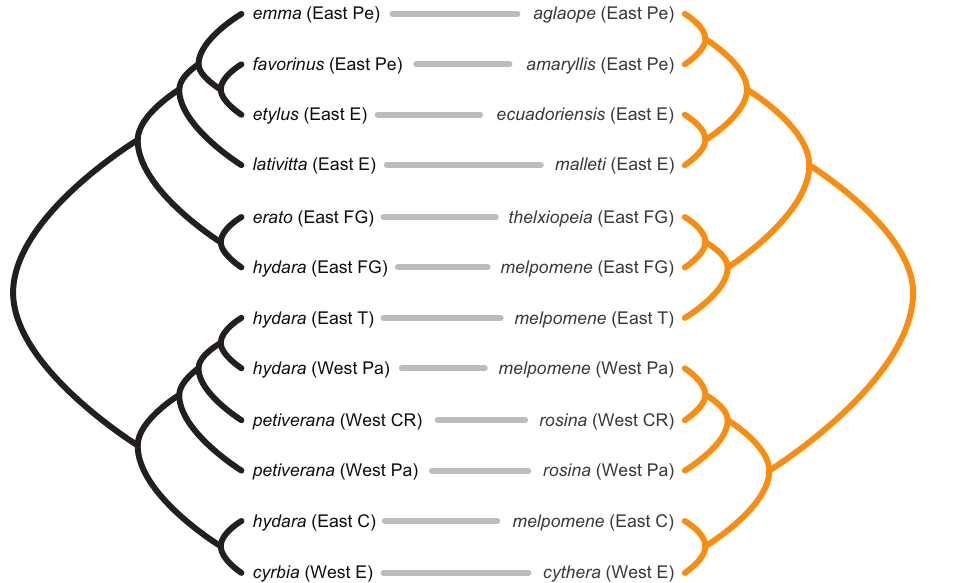
Figure 2. Phylogenies of H.erato and H.melpomene illustrating branching orders of co-mimetic country level populations within each species. Example phylogenies independently estimated for H. erato (black, left) and H. melpomene (orange, right) using the Minimise Deep Coalescence (MDC) method [32]. These correspond to cophylogenetic analysis ‘‘separate MDC countries 1’’ in Table 1. H. erato / H. melpomene co- mimics (see Figure 1) are indicated by grey lines. This is one of several possible phylogeny pairs with similarly high congruence (see Table 1). Taxon labels indicate the sampled biogeographic region (East or West of the Andes), and country (abbreviations are: CR Costa Rica, Pa Panama, E Ecuador, C Colombia, FG French Guiana, T Trinidad and Pe Peru).